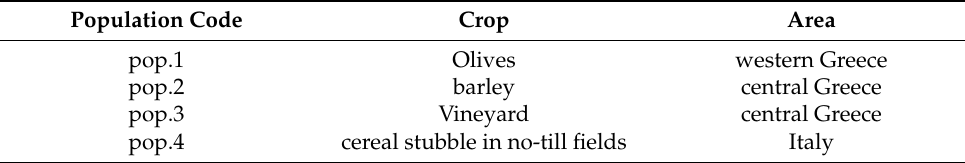
Table 1. Population code, infested crop, and area of Lolium spp. populations included in the study. Population Code Crop Area pop.1 Olives western Greece pop.2 barley central Greece pop.3 Vineyard central Greece pop.4 cereal stubble in no-till